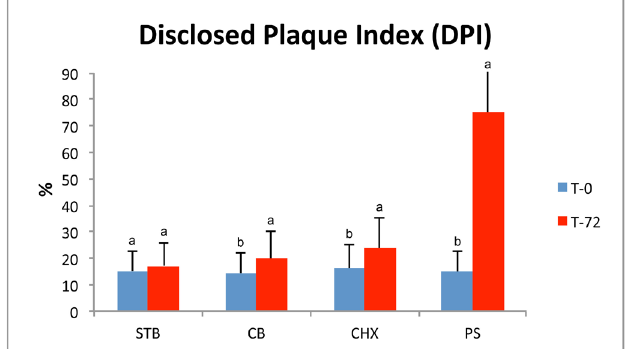
Fig.4. Mean (±SD) Disclosed Plaque Index (DPI) for the treatments at baseline (T-0) and after 72 h (T-72) for single-tuft brush (STB), conventional toothbrush (CT), chlorhexidine (CHX) and placebo solution (SP). Different lowercase letters indicate significant intragroup differences over time, by Student t test (p<0.05).